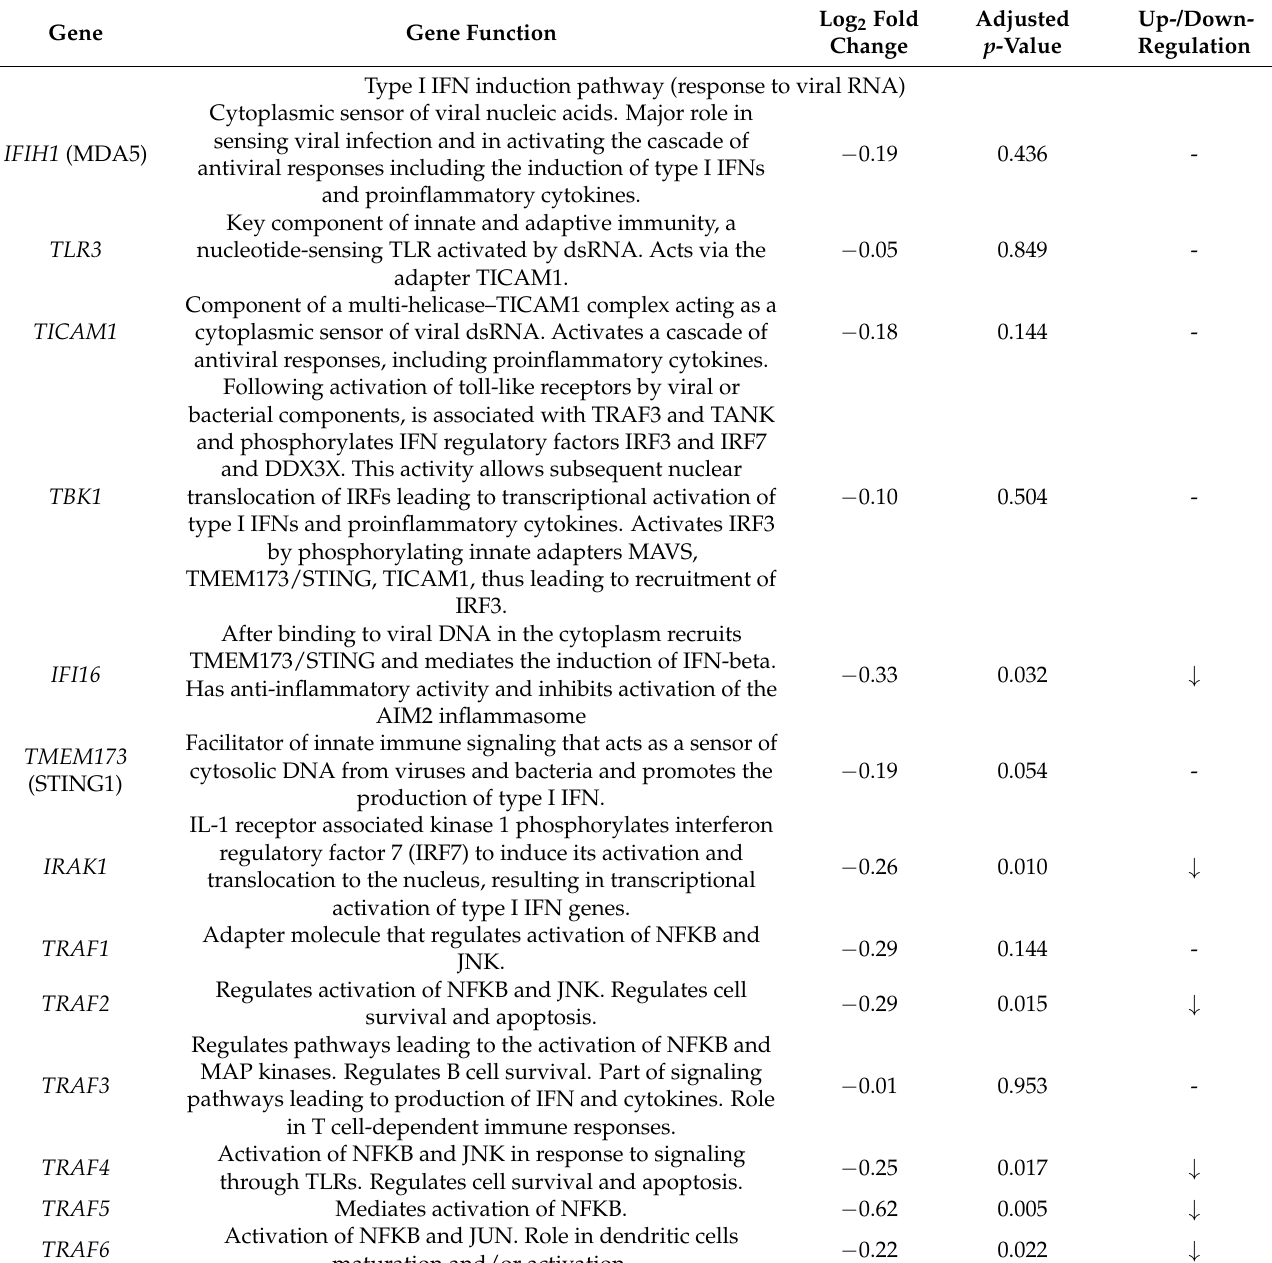
Table 3. Gene changes in type I interferon pathways. AV3 cells incubated with enterovirus strains obtained from cases of autoimmune thyroid disorders vs. AV3 cells incubated with a virus-free medium from controls without evidence of thyroid